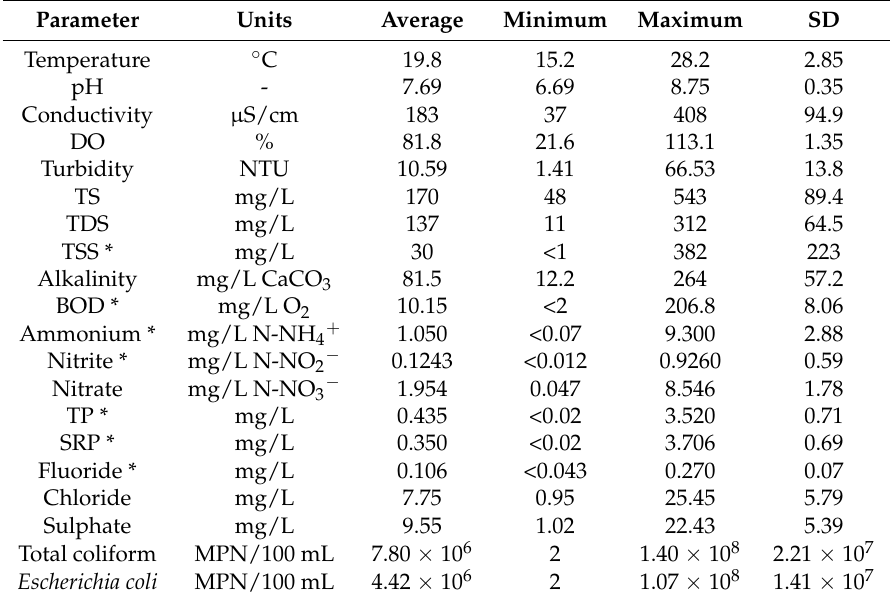
Table 1. Summary of the physical, chemical and microbiological parameters in the Virilla